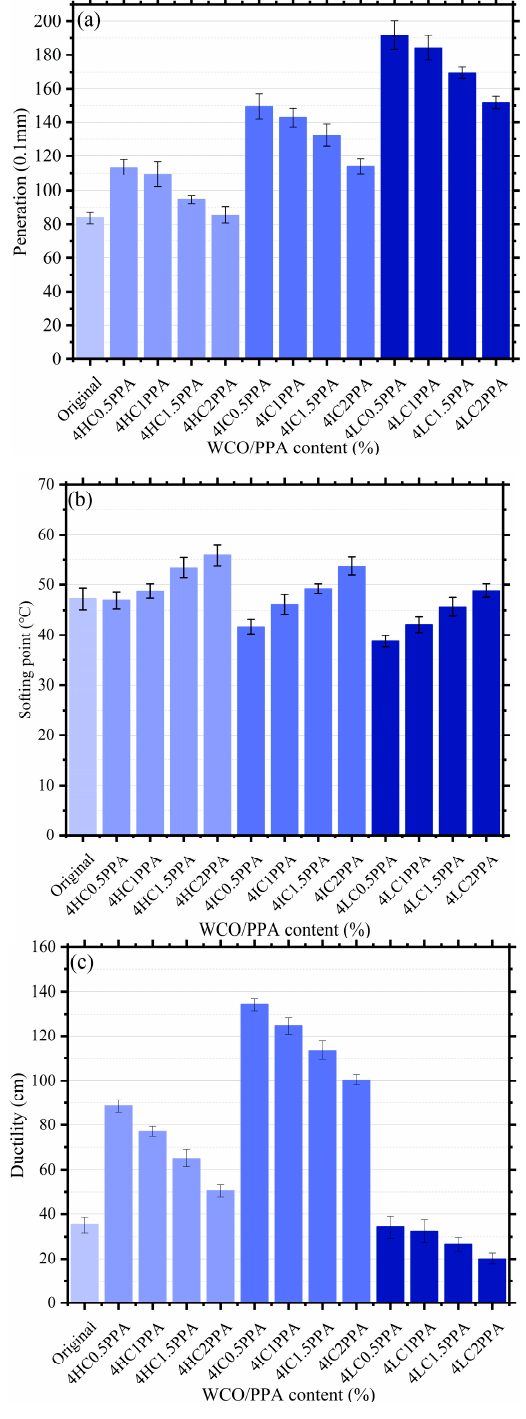
Figure 3. The results of conventional performance: ( a ) Penetration; ( b ) Softening point; ( c ) Ductility.